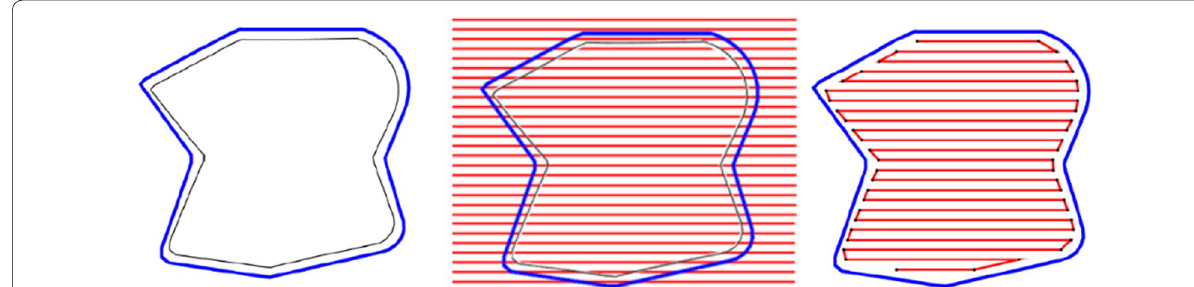
Fig. 10 Processing of the proposed zigzag tool-paths approach. For fabricating the inner area of the model, the intersection points were rearranged, and the tool-paths were then generated in step with the new positions of the intersection points within the matrix